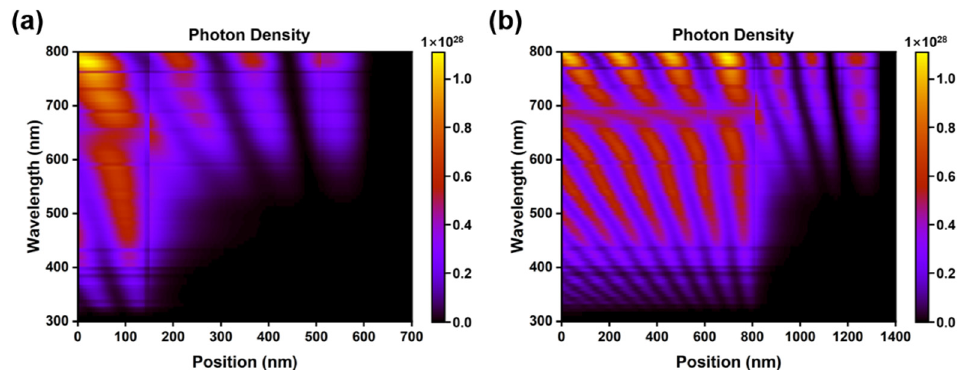
Figure 2. Simulated the photon density under AM 1.5 G illumination by GPVDM, where ( a ) are for the inverted − structure photodiode. Inset: Generation rates of photogenerated carriers at different wavelengths across perovskite active layer ( b ) are for the regular − structure photodiode.